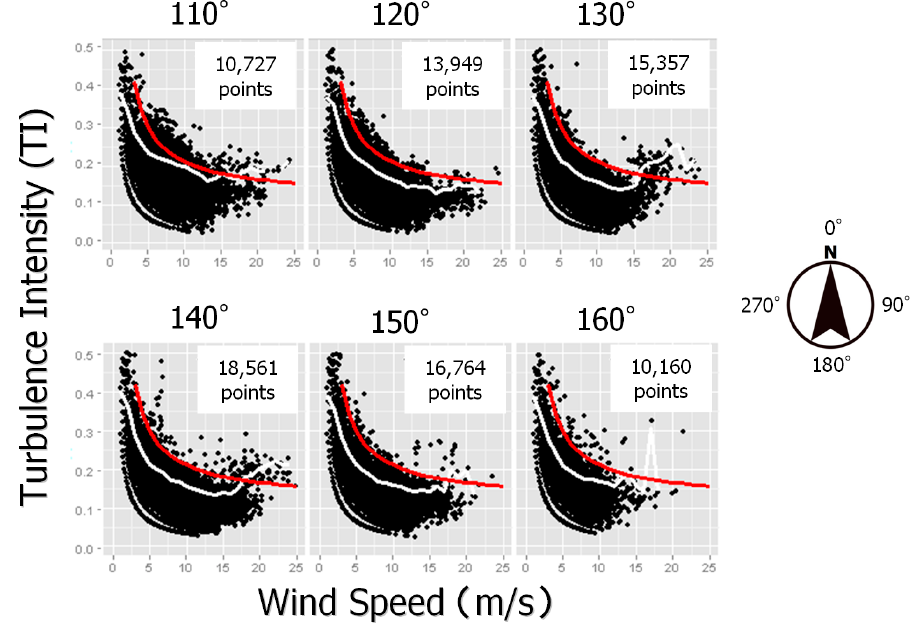
Figure 7. TI at T7 in east-south-easterly to south-south-easterly wind. The plot in the upper left panel is for a wind direction of 110°, and the plot in the lower right panel is for a wind direction of 160°.